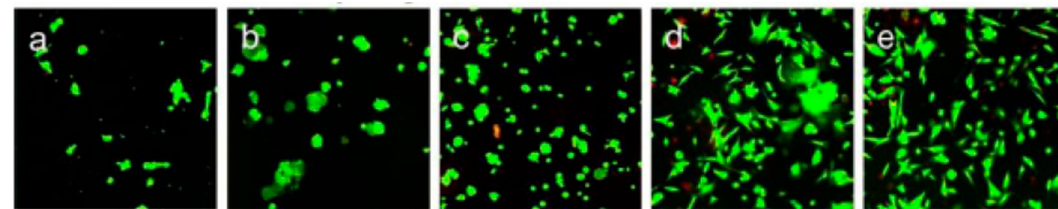
Figure 2. Fluorescence microscopy images showing changes on chondrocyte adhesiveness on hydrogels with different concentrations of MAETAC ranging from 0% ( a ), 5% ( b ), 10 % ( c ), 20 % ( d ), and 30% ( e ). Reprinted from reference [48] with permission from Elsevier.